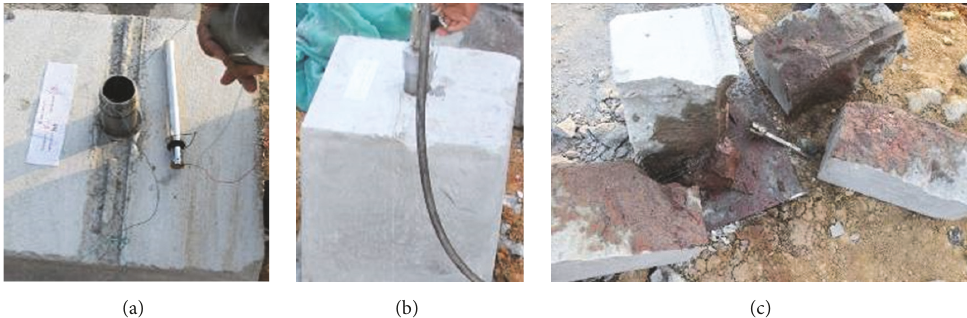
Figure 11: The results of the pressured water coupling blasting in the A2B2C1 case: (a) before being blasted; (b) tube connection; (c) after being blasted.